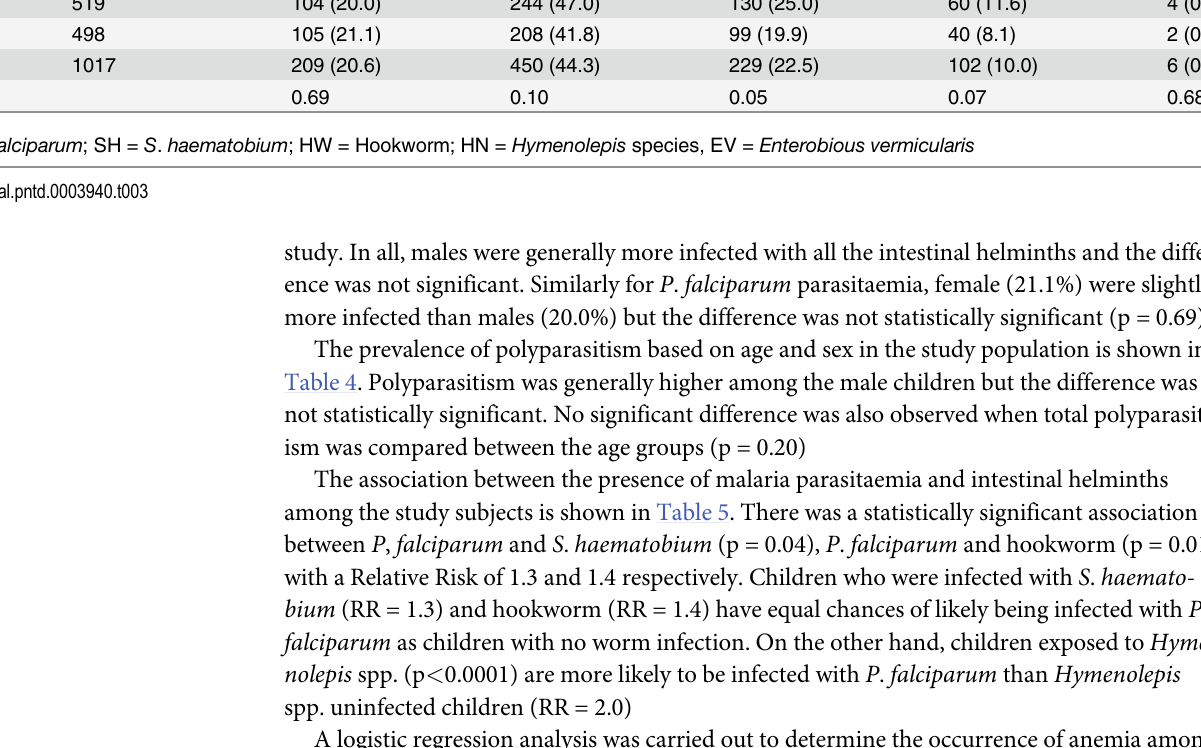
Table 3. Prevalence of single parasitic infection among children by sex.